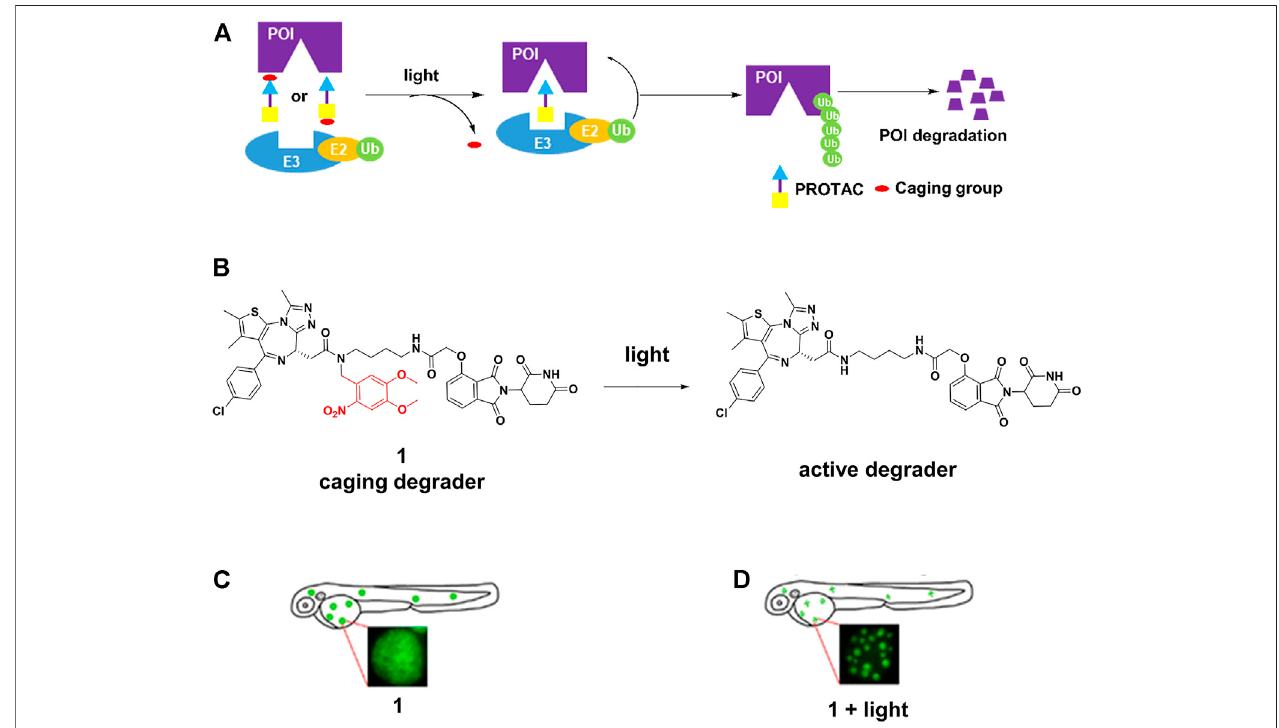
FIGURE 1 | (A) Action mode of caging PROTACs. (B) Uncaging reaction of caging degrader 1 . (C) Degradation of BRD4-EGFP fusion protein through 1 without light irradiation in zebra fi sh embryos (Adapted with permission from (Xue et al., 2019). Copyright (2019) American Chemical Society). (D) Degradation of BRD4-EGFP fusion protein through 1 with light irradiation in zebra fi sh embryos (Adapted with permission from (Xue et al., 2019). Copyright (2019) American Chemical Society.).